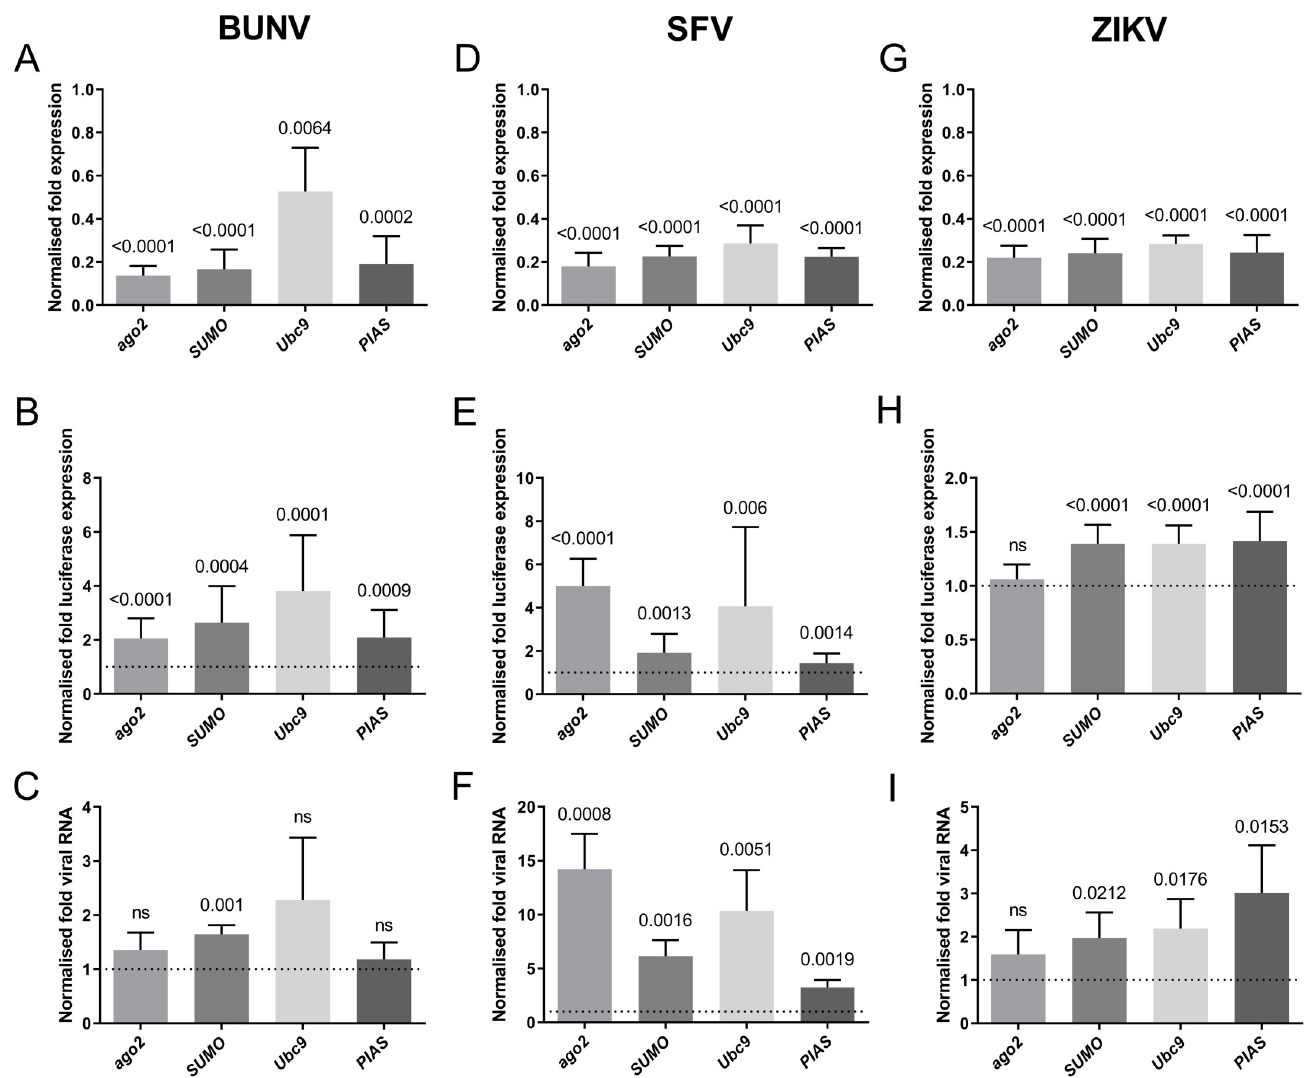
Fig 5. Aa SUMOylation effector proteins suppress arbovirus replication in Ae . aegypti cells. AF5 cells were treated with dsRNA targeting SUMO , Ubc9 , PIAS , LacZ (non-target negative control), or a go2 (positive control) for 72 hours prior to infection (MOI 0.05 PFU/cell) with BUNV, SFV, or ZIKV luciferase reporter viruses. Cells were harvested at 48 hours post-infection for luciferase and RT-qPCR analysis. (A,D,G) RT-qPCR analysis of mRNA levels of ago2 , SUMO , Ubc9 , or PIAS within infected AF5 cells. N = 5 independent biological replicates; values normalized to ribosomal S7 and expressed relative to dsLacZ-treated control samples; RQ mean and SD plotted. (B, E, H) Luciferase readings from BUNV, SFV, or ZIKV infected samples. N = 15 independent biological replicates per condition; values expressed relative to dsLacZ-treated control samples (set to 1, dotted line); mean and SD plotted. (C, F, I) Viral RNA (vRNA) levels from BUNV, SFV, or ZIKV infected samples. N = 5 independent biological replicates; values expressed relative to dsLacZ-treated control samples (set to 1, dotted line); RQ mean and SD plotted. Statistical analysis, one sample (two-tailed) t test to a hypothetical mean of 1 (dsLacZ control), significant probability (P) values ( � 0.05) shown; ns = not significant.